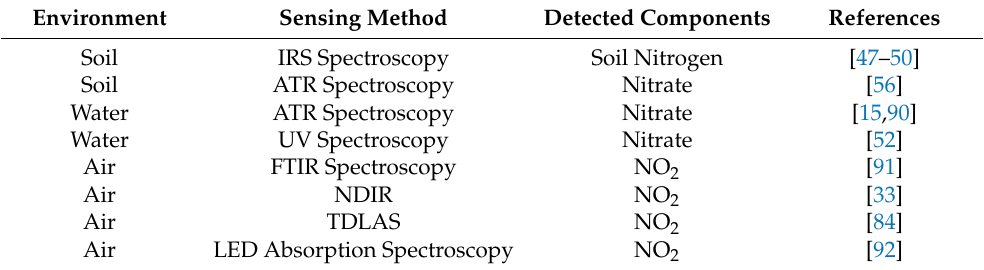
Table 1. Optical sensing methods in various